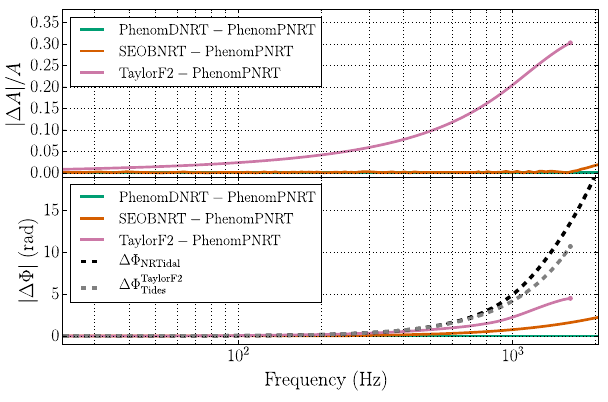
FIG. 2. Relative amplitude and phase of the employed wave- form models starting at 23 Hz (see Table I) with respect to PhenomPNRT after alignment within the frequency interval ½ 30 ; 30 . 25 (cid:2) Hz. Note that, in particular, the alignment between SEOBNRT and PhenomPNRT is sensitive to the chosen interval due to the difference in the underlying BBH-baseline models at early frequencies. We show, as an example, an equal-mass, nonspinning system with a total mass of 2 . 706 M ⊙ and a tidal ˜ Λ ¼ 400 deformability of . In the bottom panel, we also show the tidal contribution to the phasing for the TaylorF2 and the NRTidal models. This contribution can be interpreted as the phase difference between the tidal waveform models and the corre- sponding BBH models. The TaylorF2 waveform terminates at the frequency of the innermost stable circular orbit, which is marked by a small